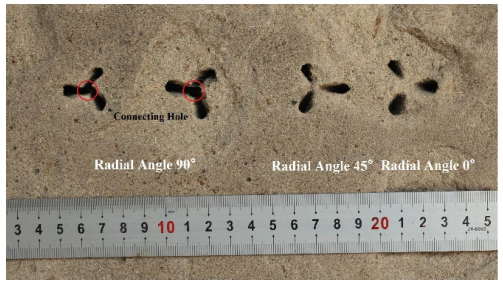
Figure 9. Pattern of holes broken in sandstone with different forward orifice radial angles. Note that the nozzles with the 90 ˝ radial angle orifices broke out the center zone of the target (red circles) whereas the 45 ˝ and 0 ˝ radial angle nozzles did not.